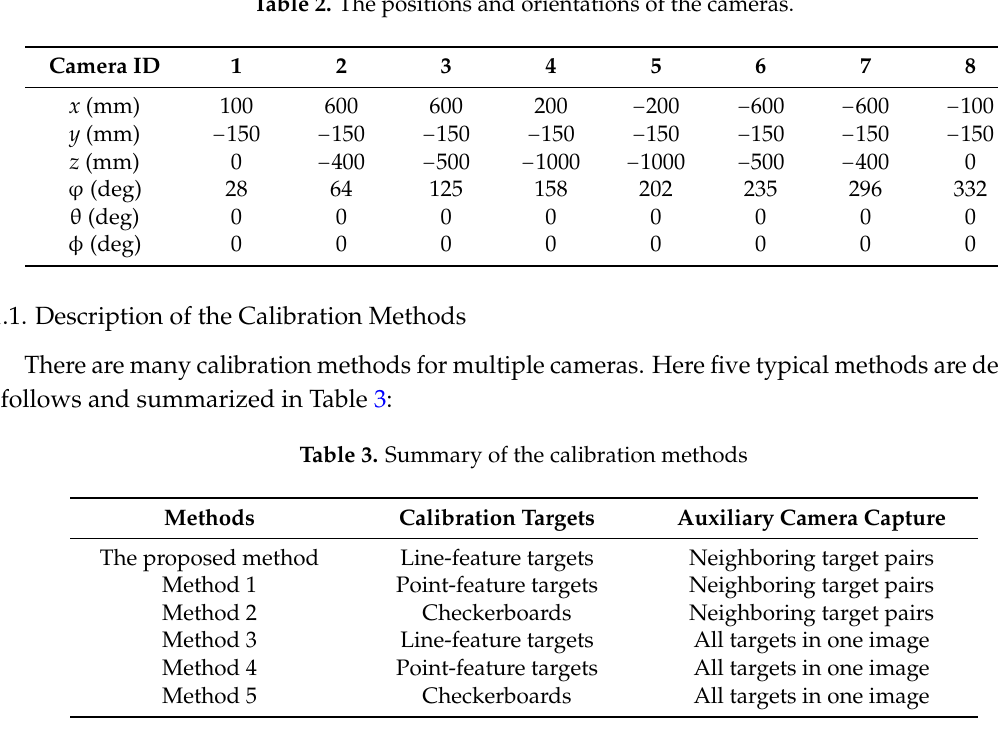
Table 2. The positions and orientations of the cameras.